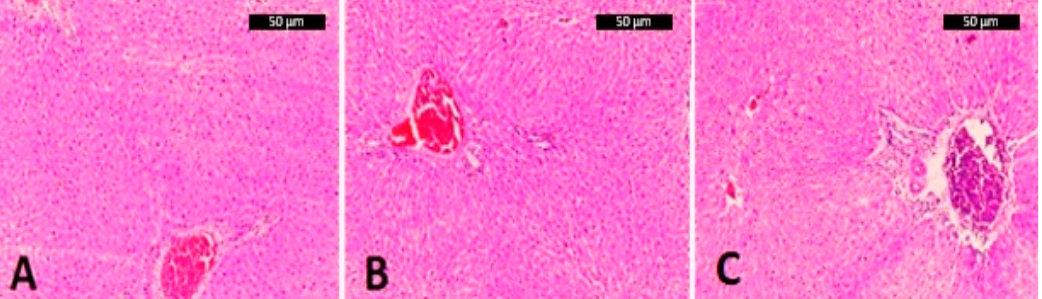
Figure 4. Effect of Camellia sinensis and Passiflora ligularis Juss (green tea and granadilla) polyphenol- extracts on hepatic histological condition after treatments. ( A ): group control, ( B ): 3.0 g/L green tea, ( C ): 3.0 g/L granadilla.